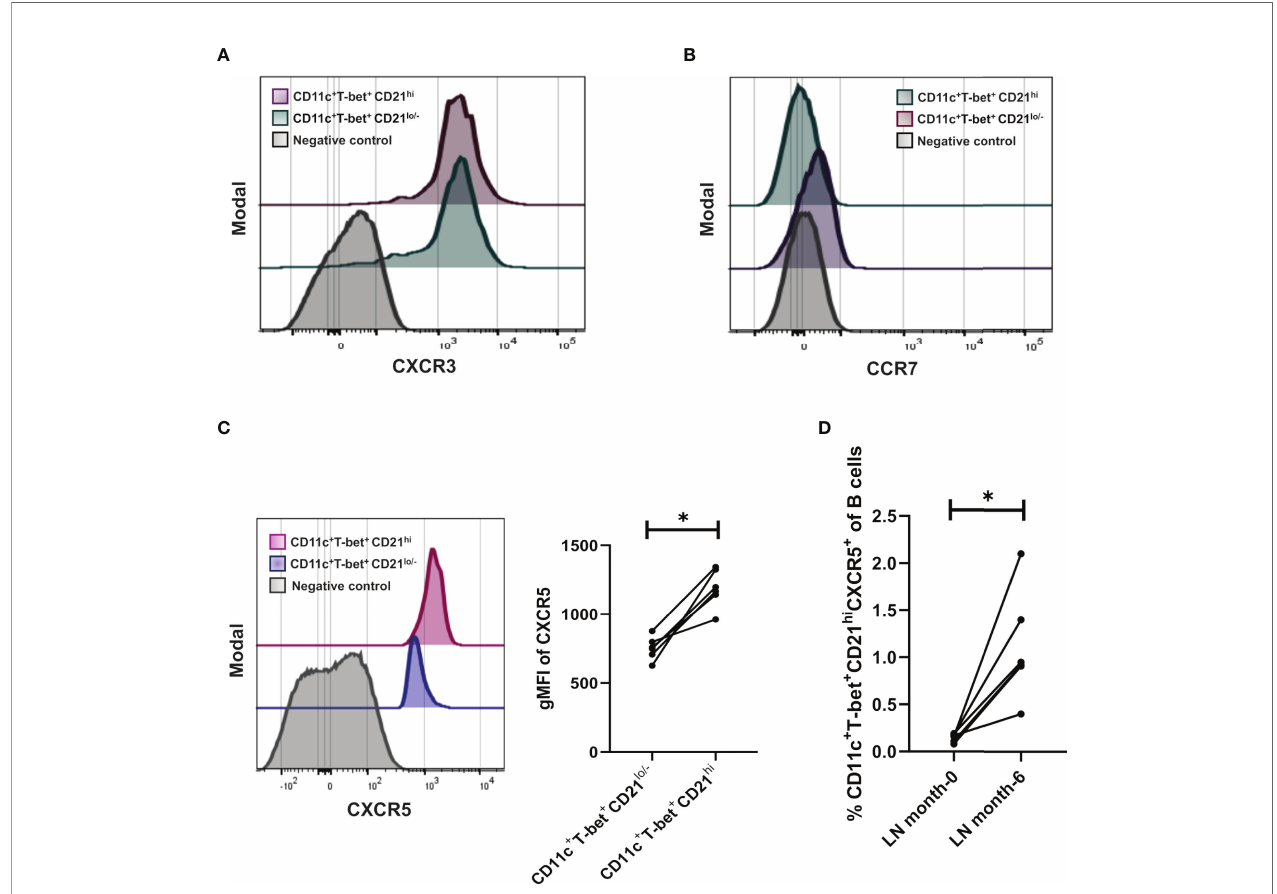
FIGURE 4 | Density expression of chemokine receptors CXCR3, CCR7 and frequencies of CXCR5 in the CD21 hi subset. (A) Representative histogram of treated LN patients (n=7 responders) to evaluate density expression of CXCR3 between ABCs and CD21 hi subsets. (B) Representative histogram of treated LN patients to evaluate density expression of CCR7 between ABCs and CD21 hi subsets. (C) Representative histogram of a treated LN patient to evaluate density expression of CXCR5 between ABCs and CD21 hi subsets; further comparative analysis of CD21 gMFI of the mentioned subsets. (D) Comparative analysis of CXCR5 frequencies over the CD21 hi subset between patients at the beginning of induction therapy and the same patients after 6 months treated. All comparative analysis were assessed by a Wilcoxon test. *p ≤